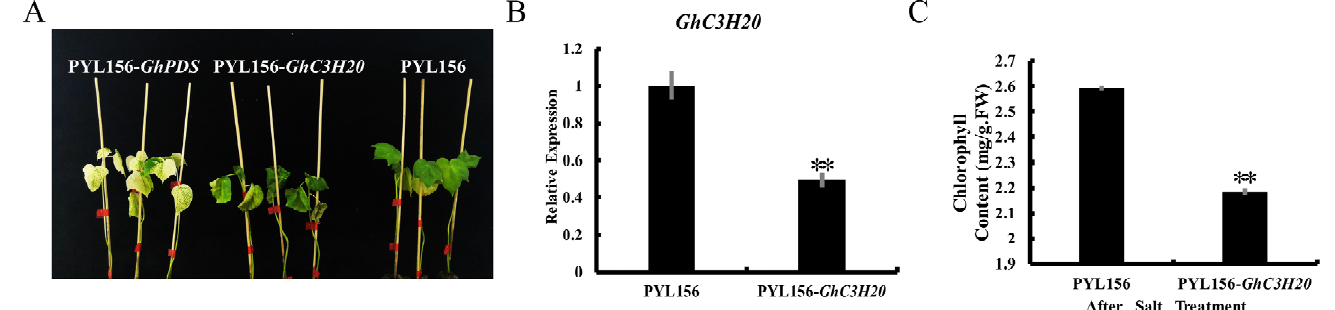
Figure 6. Silencing of GhC3H20 decreased salt stress tolerance in cotton. ( A ) Leaf whitening of positive control plants (plants injected with pYL156- GhPDS vector), and phenotype analysis of control plants and silent plants under 400 mM NaCl treatment. ( B ) The relative expression levels of control plants and silenced plants in cotton leaves. ( C ) The content of chlorophyll in leaves of control plants and silenced plants under 400 mM NaCl treatment. The error bars represent standard deviations of three biological replicates (** p <0.01, Student’s t -test).